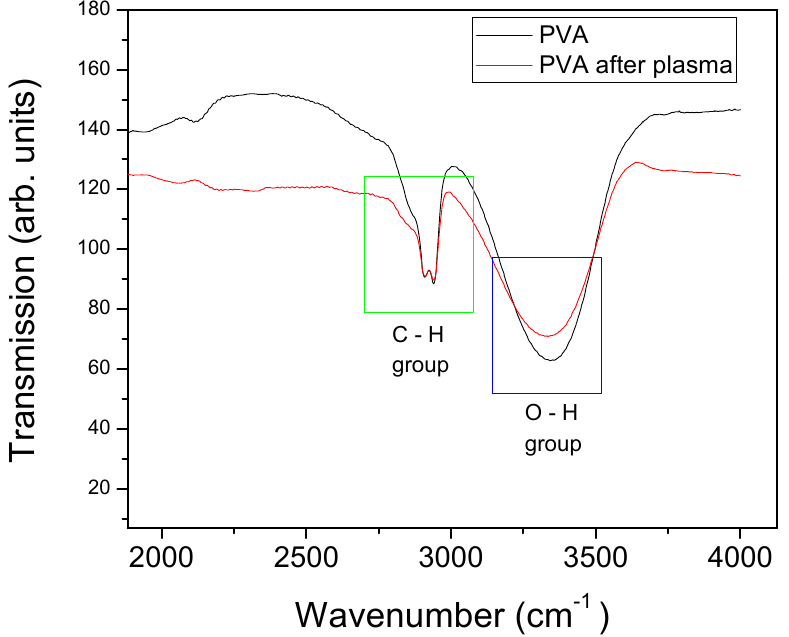
Figure 10. FT-IR transmission spectrum of the PVA polymer before and after plasma treatment. Figure 10 represents the FT-IR transmission spectrum of the PVA layer before and